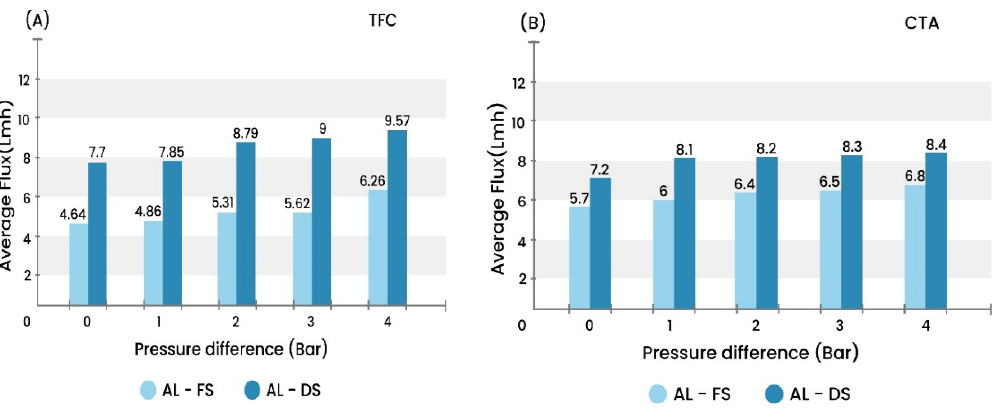
Figure 6. The average membrane flux calculated at different applied pressures of FO process using ( A ) TFC membrane and ( B ) CTA membrane in both orientations, AL-FS and AL-DS.